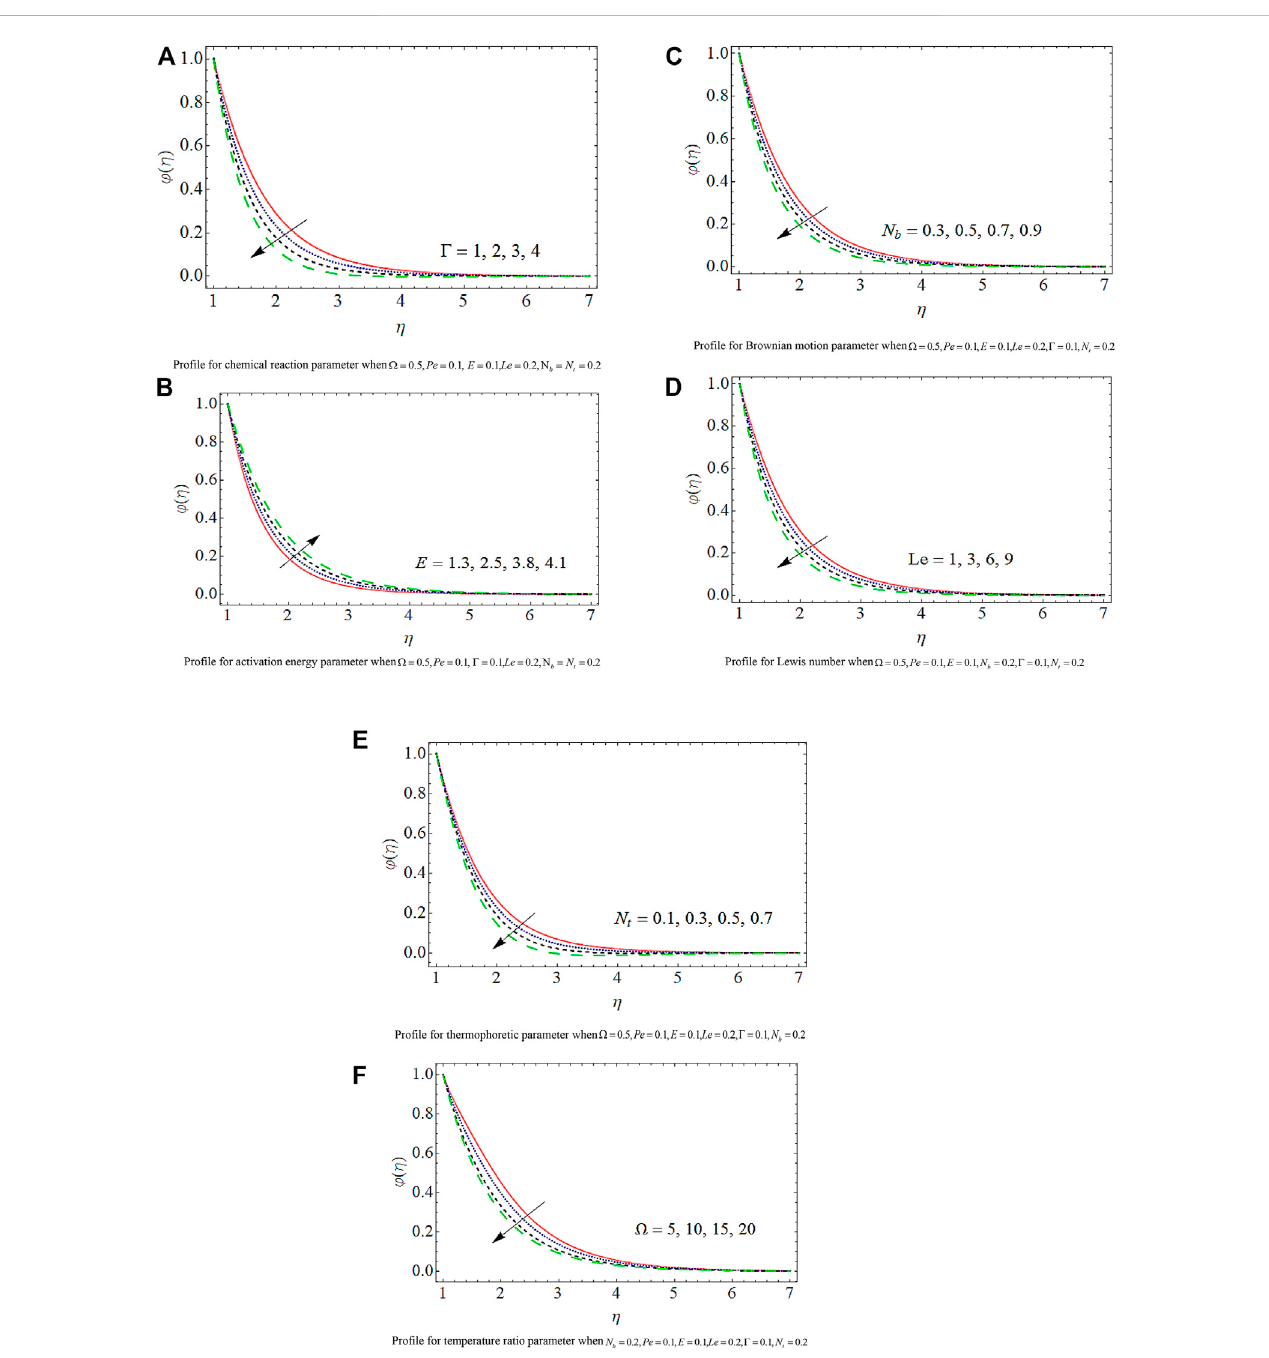
FIGURE 4 Concentration pro fi les under the impact of various substantial